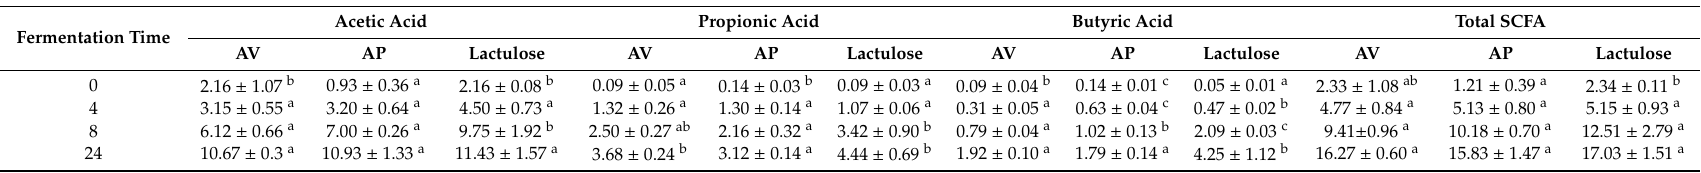
Table 4. Concentration of SCFA ( µ mol / mg) produce during the fermentation of Aloe vera gel (AV), its polysaccharide extract (AP) and lactulose as a carbon